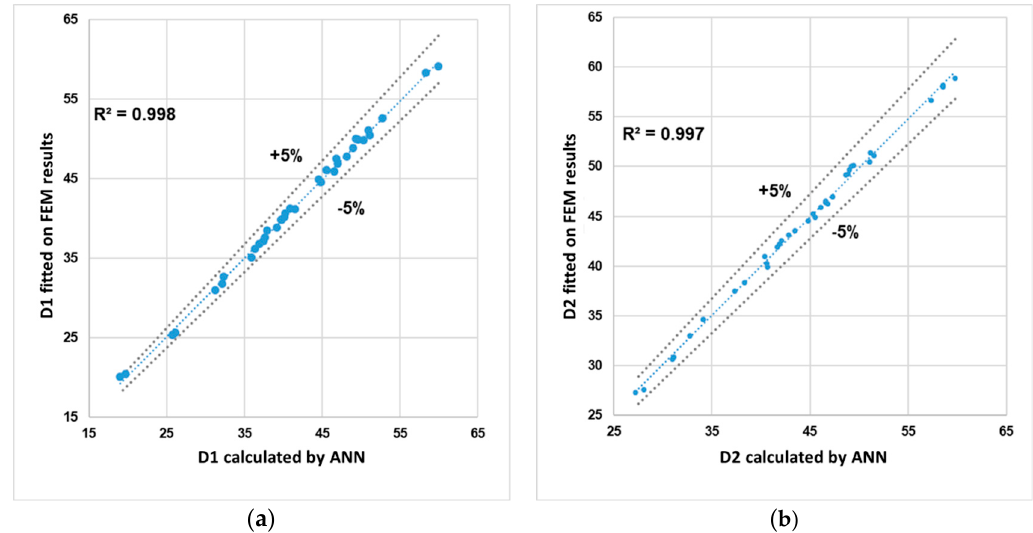
Figure 7. Plot of D1 from the analytical model D1 (target) versus the ANN trained D1 in blue with error bands at +5% and − 5% in grey ( a ) and the analytical model D2 (target) versus the ANN trained D2 in blue with error bands at +5% and − 5% in grey ( b ).